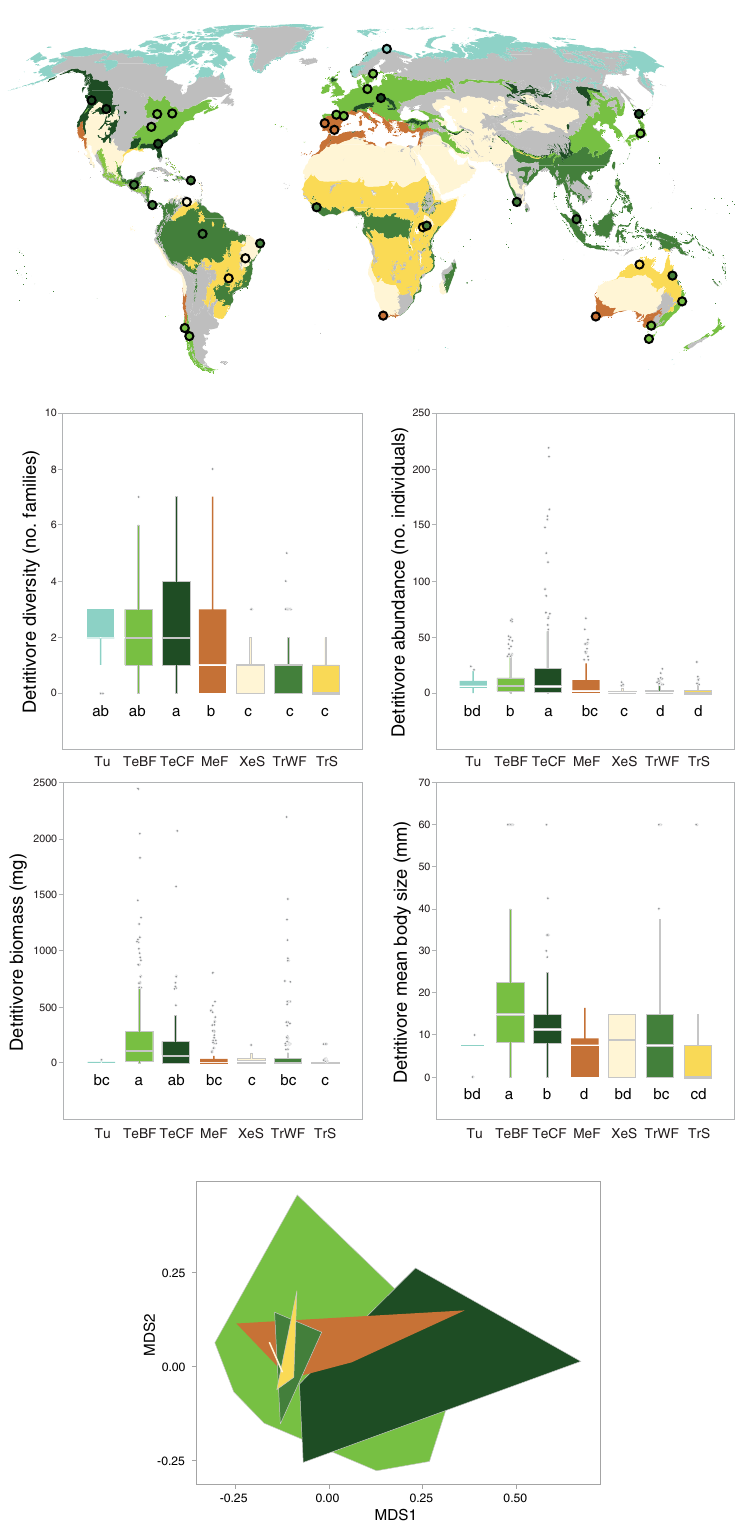
Fig. 3 Global distribution of study sites in different biomes (Tu, tundra; TeBF, temperate broadleaf forest; TeCF, temperate coniferous forest; MeF, Mediterranean forest; XeS, xeric shrubland; TrWF, tropical wet forest; TrS, tropical savanna); n = 38. Box plots show the median, interquartile range and minimum-maximum range of litter-consuming detritivore diversity (number of families per litterbag), abundance (number of individuals per litterbag), biomass (mg per litterbag) and mean body size (mm) in each biome (ordered from highest to lowest diversity); different letters indicate signi fi cant differences. The NMDS ordination of litter-consuming detritivores with biomes is represented by polygons of different colours as in maps and box plots. Signi fi cant differences in assemblage structure were: TrWF vs. TeBF, TeCF,